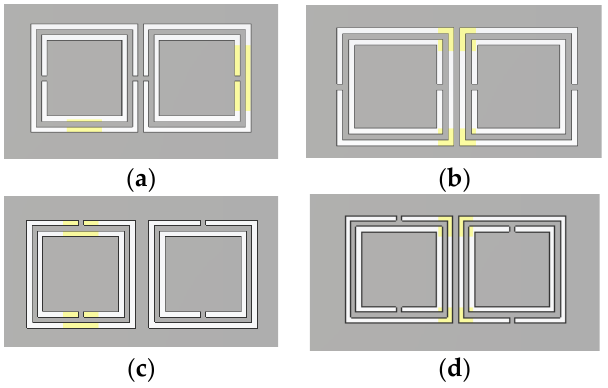
Figure 14. Topologies of couples of SCSRRs. ( a ) face-to-face, ( b ) back-to-back, ( c ) side-by-side, ( d ) side-by-side reversely.